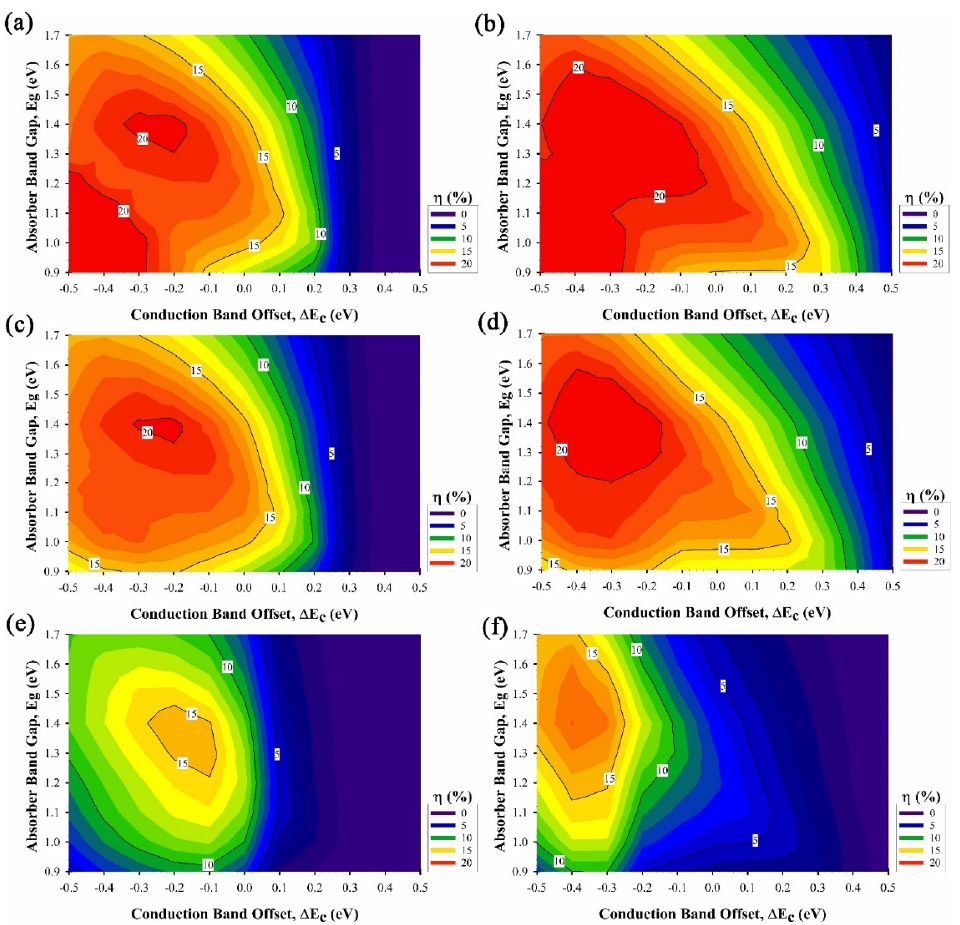
Figure 6. Effect of µ and N D of the CdS buffer layer on the conversion efficiency of thin film solar cell with practical p-absorber layer having a different bulk defect density (BDD). ( a ) CdS-Set A and BDD: 10 14 cm −3 , ( b ) CdS-Set D and BDD: 10 14 cm −3 , ( c ) CdS-Set A and BDD: 10 16 cm −3 , ( d ) CdS-Set D and BDD: 10 16 cm −3 , ( e ) CdS-Set A and BDD: 10 18 cm −3 and ( f ) CdS-Set D and BDD: 10 18 cm −3 .